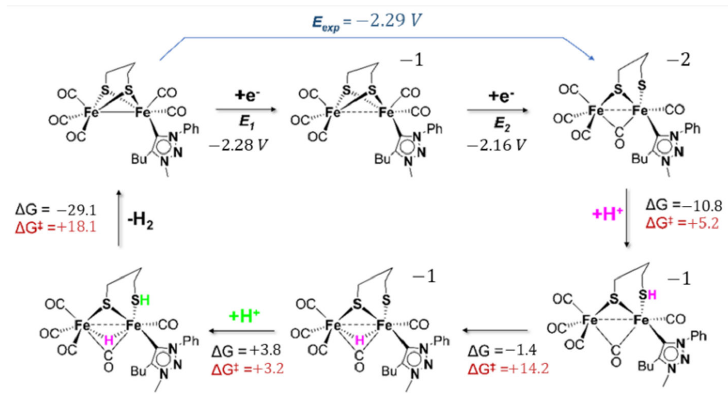
Figure 7. Proposed catalytic cycle for proton